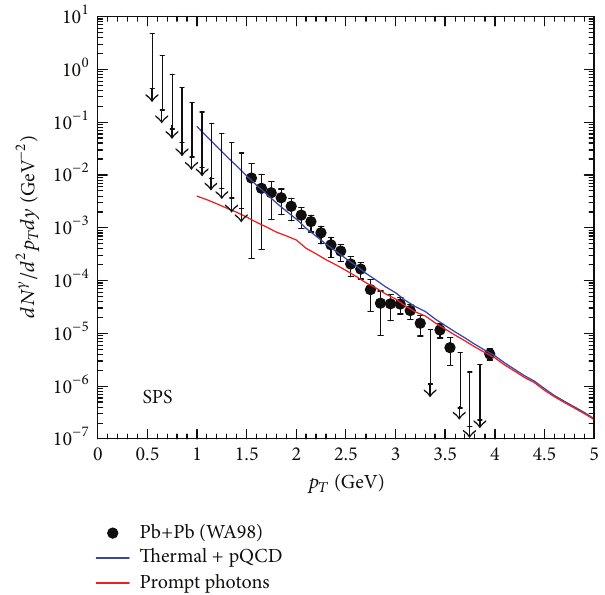
Figure 6: Transverse momentum spectra of photon at SPS energy for Pb+Pb collision at midrapidity